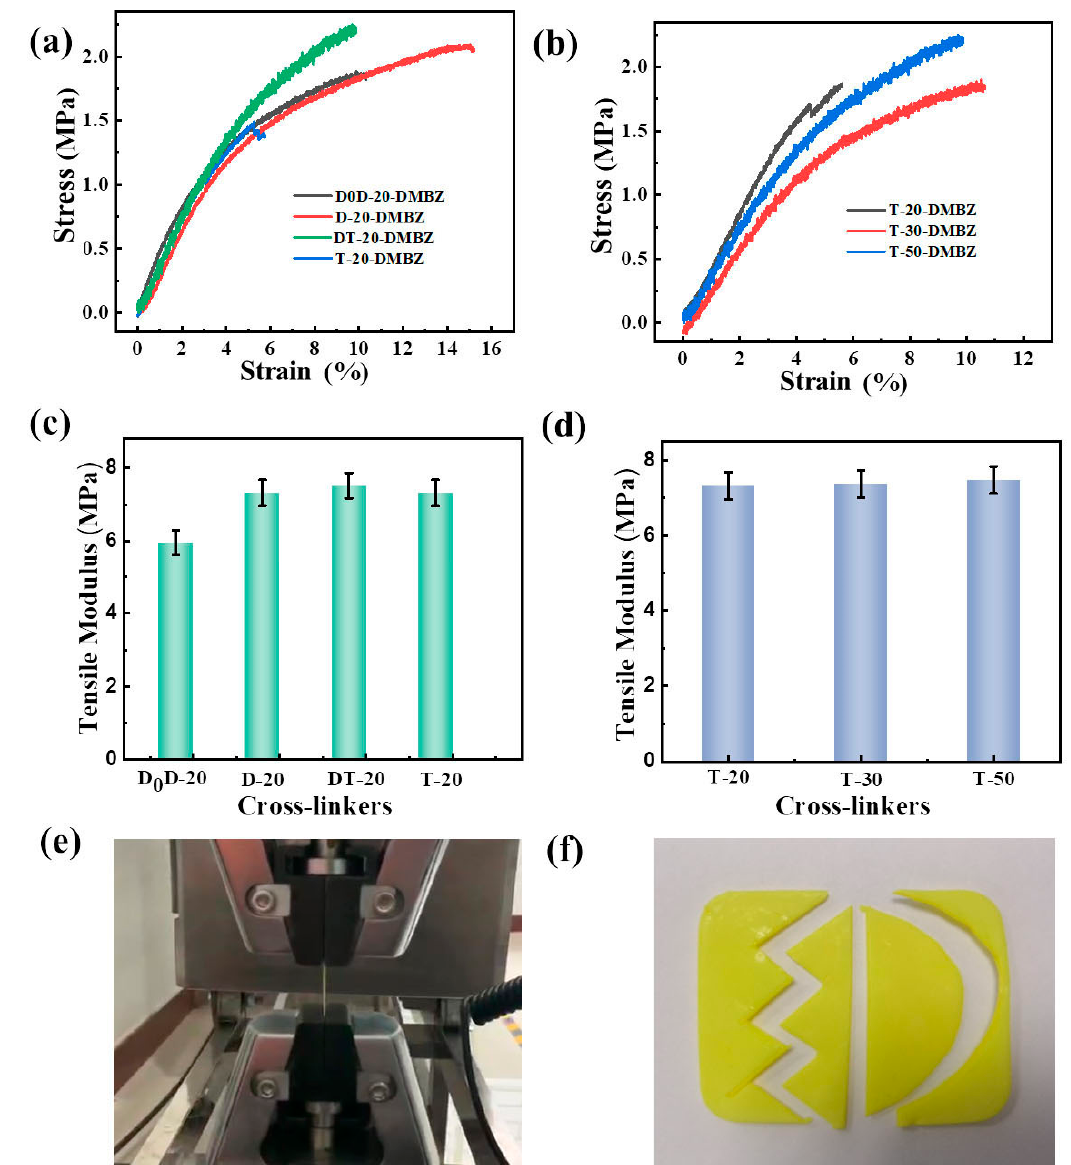
Figure 6. ( a ) Stress–strain curves from stretching of polyimide aerogels cross-linked with silicone polymers prepared from different precursors; ( b ) Stress − strain curves from stretching of polyimide aerogels cross-linked with silicone polymers prepared with silicone polymers of different degrees of polymerization; ( c ) Tensile modulus of polyimide aerogels cross-linked with silicone polymers prepared from different precursors; ( d ) Tensile modulus of polyimide aerogels prepared with silicone polymers of different degrees of polymerization; ( e ) Polyimide aerogel thin film of D-20-1:1 after folding; ( f ) Demonstration of the cutting properties of